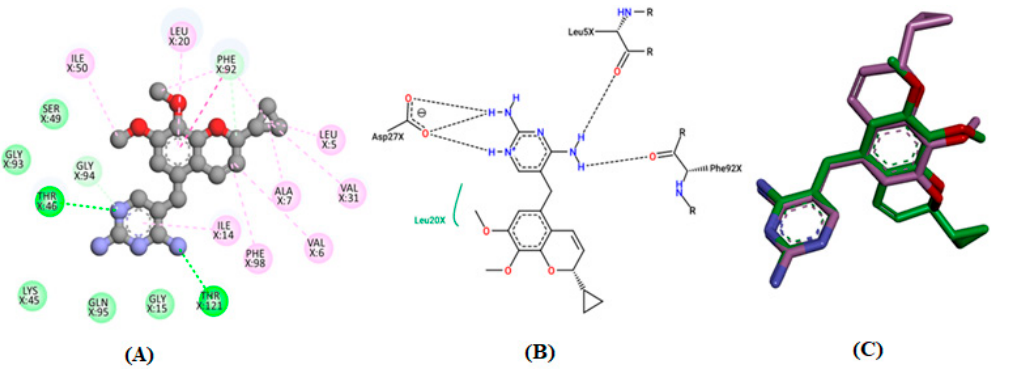
Figure 5. The results of intermolecular interaction between 1JIJ.pdb protein and co-crystallized ligand, which are produced computationally ( A ) and experimentally ( B ), and the result of superposition pose with RMSD of 1.948 Å ( C ).